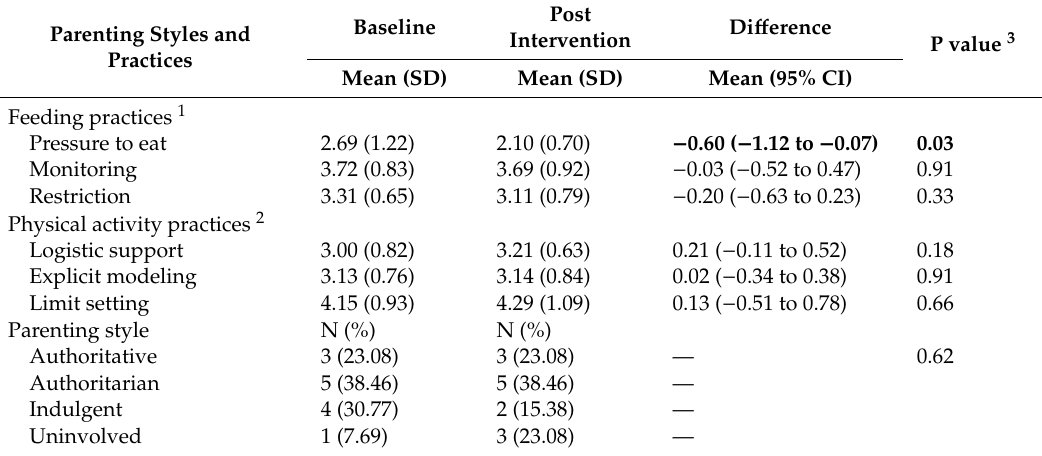
Table 3. Changes in parenting style and practices in nutrition and physical activity in parents of pediatric patients of acute lymphoblastic leukemia (ALL), the Healthy Eating and Active Living (HEAL) pilot